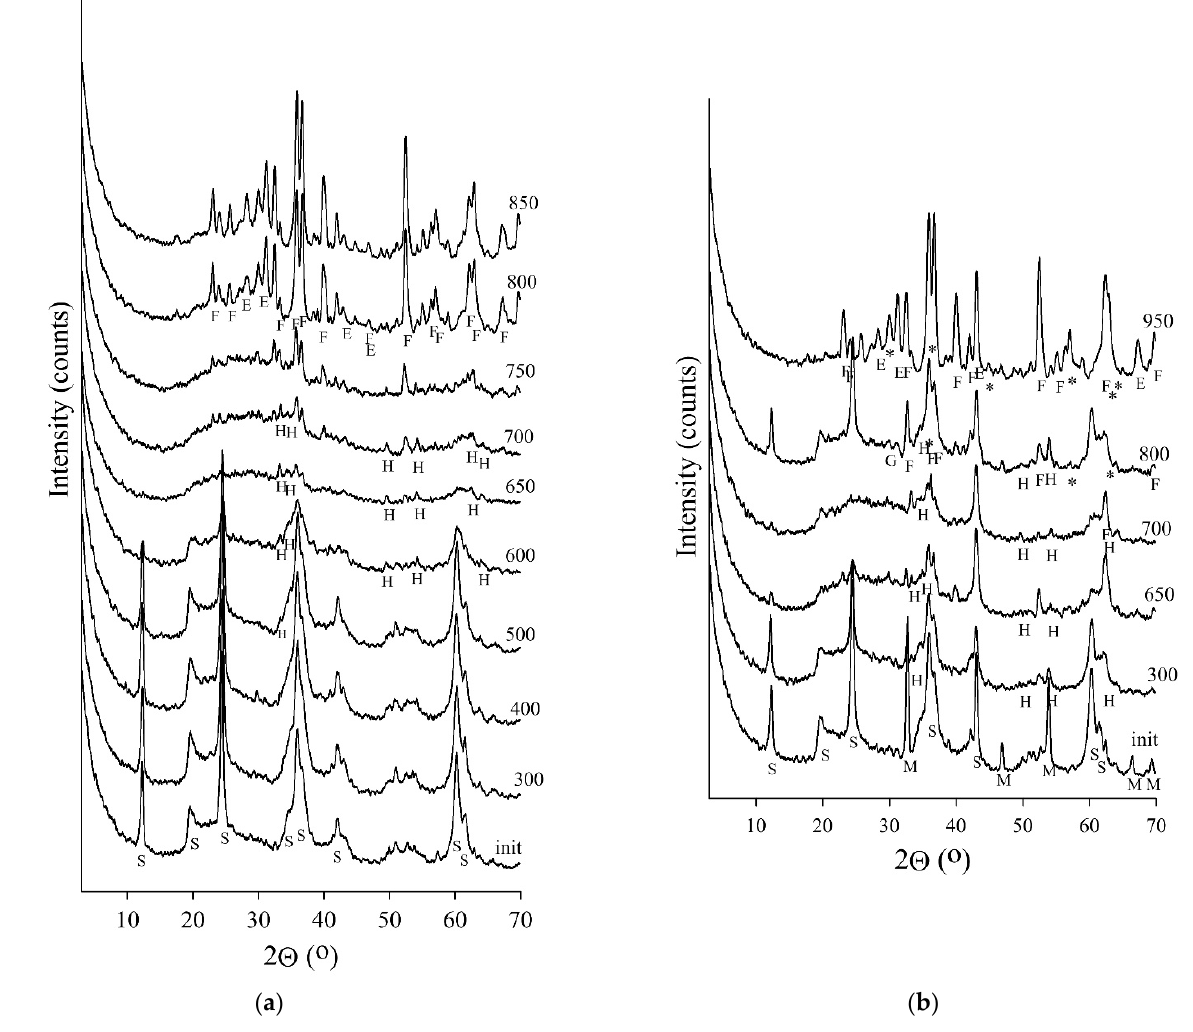
Figure 1. XRD analysis of samples of ( a )—MF and ( b )—RF series S-Chrysotile; F—Forsterite; E—Enstatite; H—Hematite; M—Magnesite; *—Magnetite.